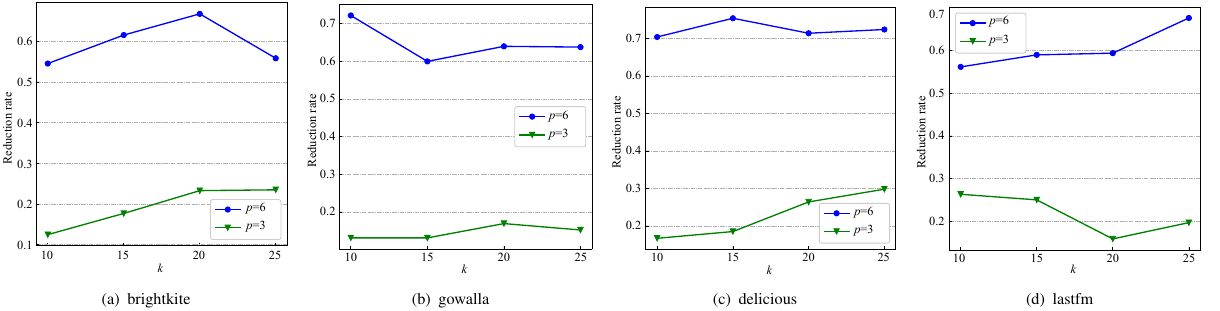
Fig. 3 Reduction rate of P-MICS comparing with MICS.